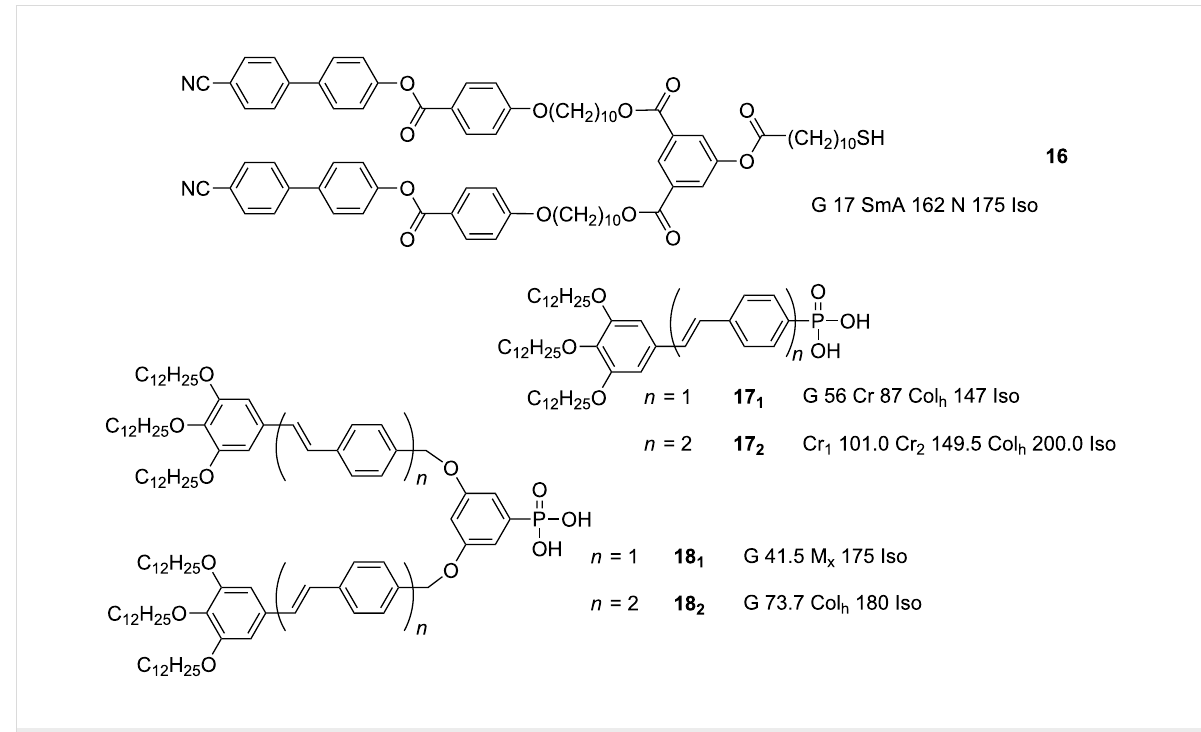
Figure 19: Chemical structures and mesogenic properties of dendritic and proto-dendritic ligands used to coat NPs.